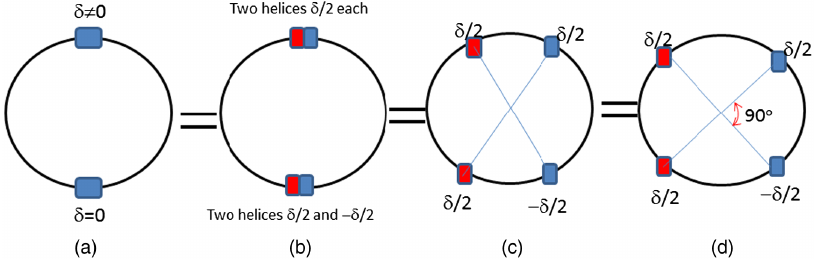
FIG. 2. Each picture shows partial helix arrangement in a synchrotron. The equal signs between the pictures indicate that the helix arrangement shown in each picture provides equivalent spin tune. The arrangement of the helices in the last picture (d) provides an optimum beam optics for the